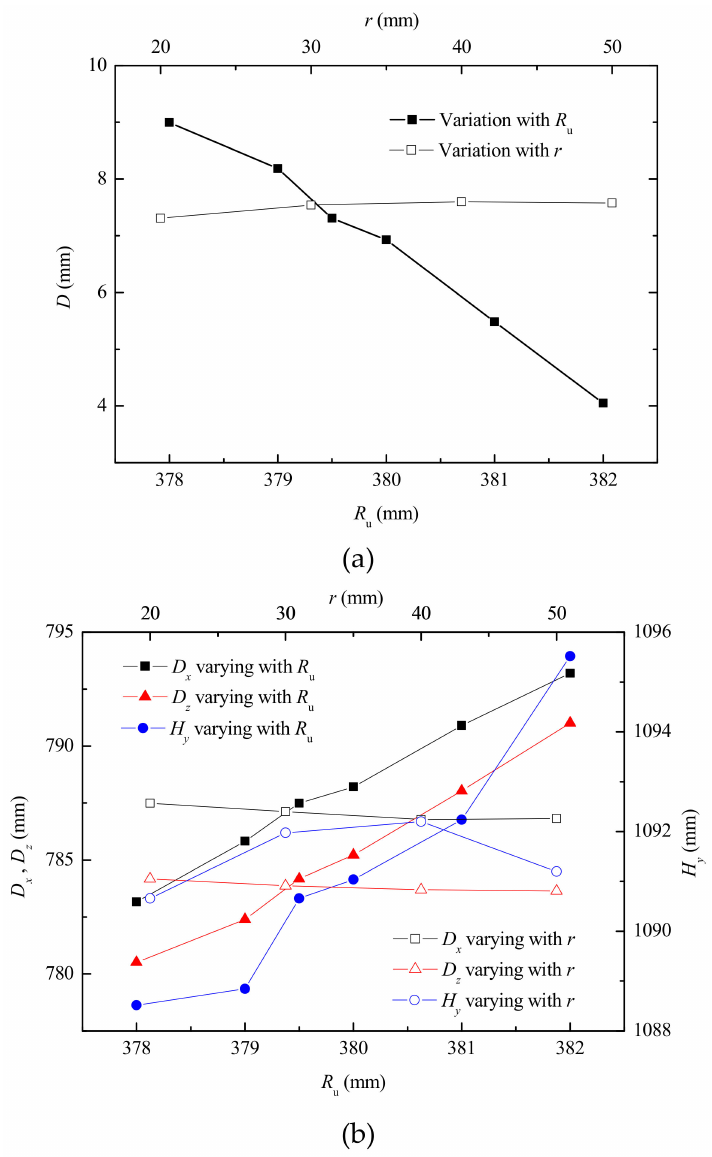
Figure 14. Influence of geometry of upper die ( a ) on index D and ( b ) on size of